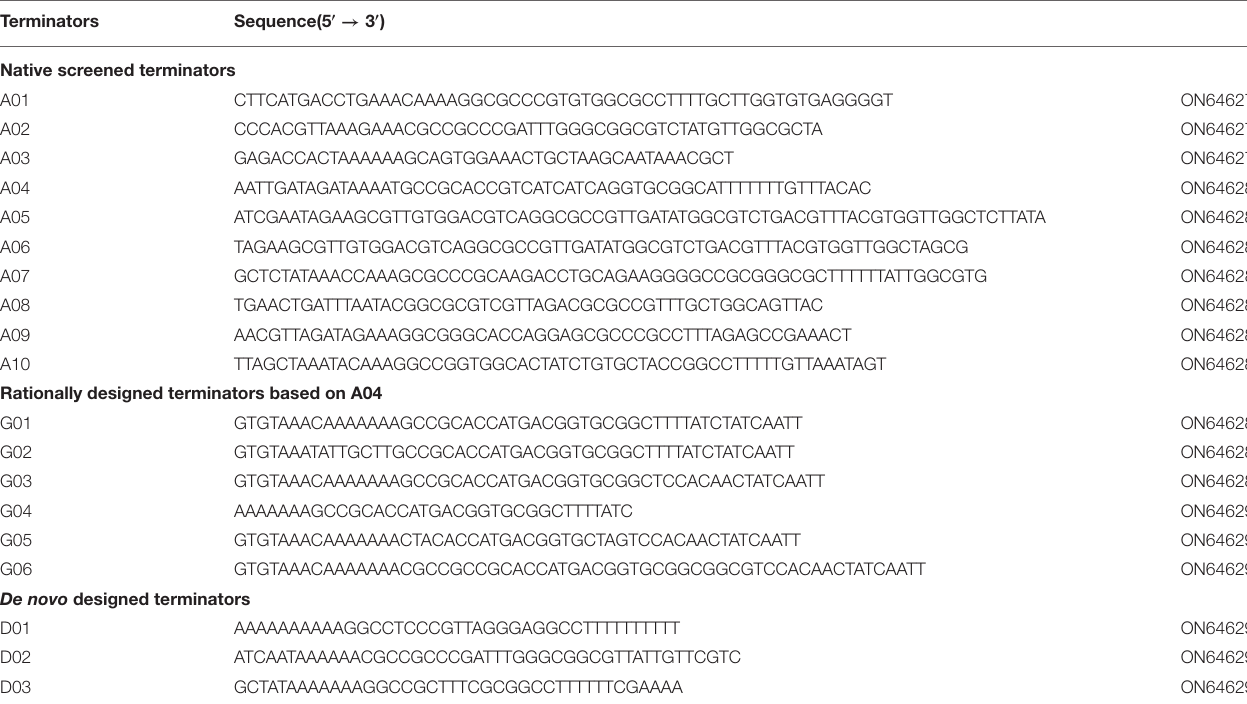
TABLE 2 | Sequences of all native or designed terminators for H. bluephagenesis in this